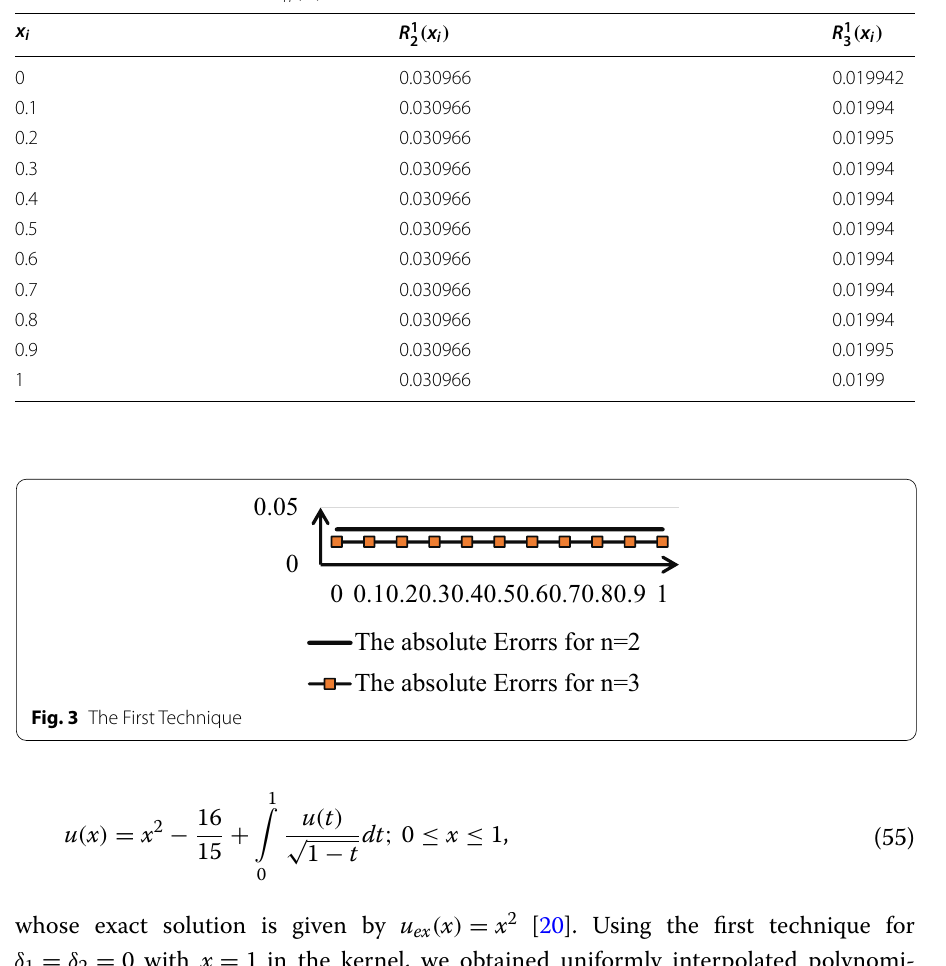
Table 3 The absolute errors R 1 n ( x i ) for n = 2,